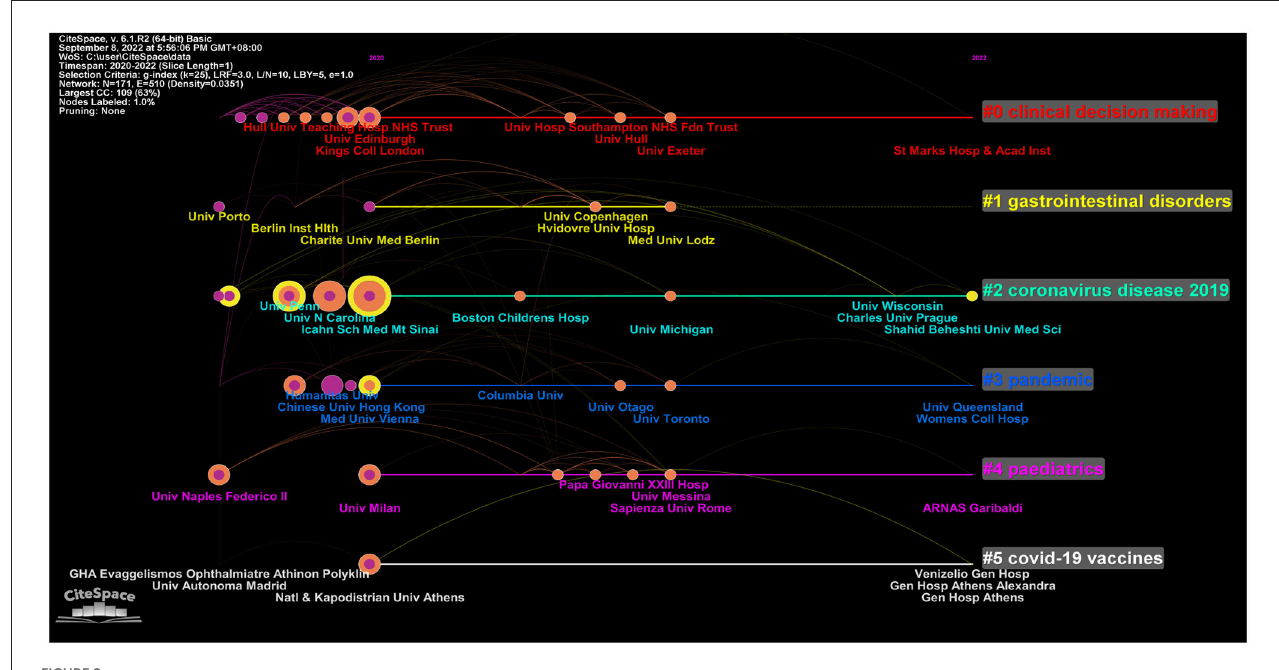
FIGURE2 Network visualization of cooperative institutions in the field of IBD and